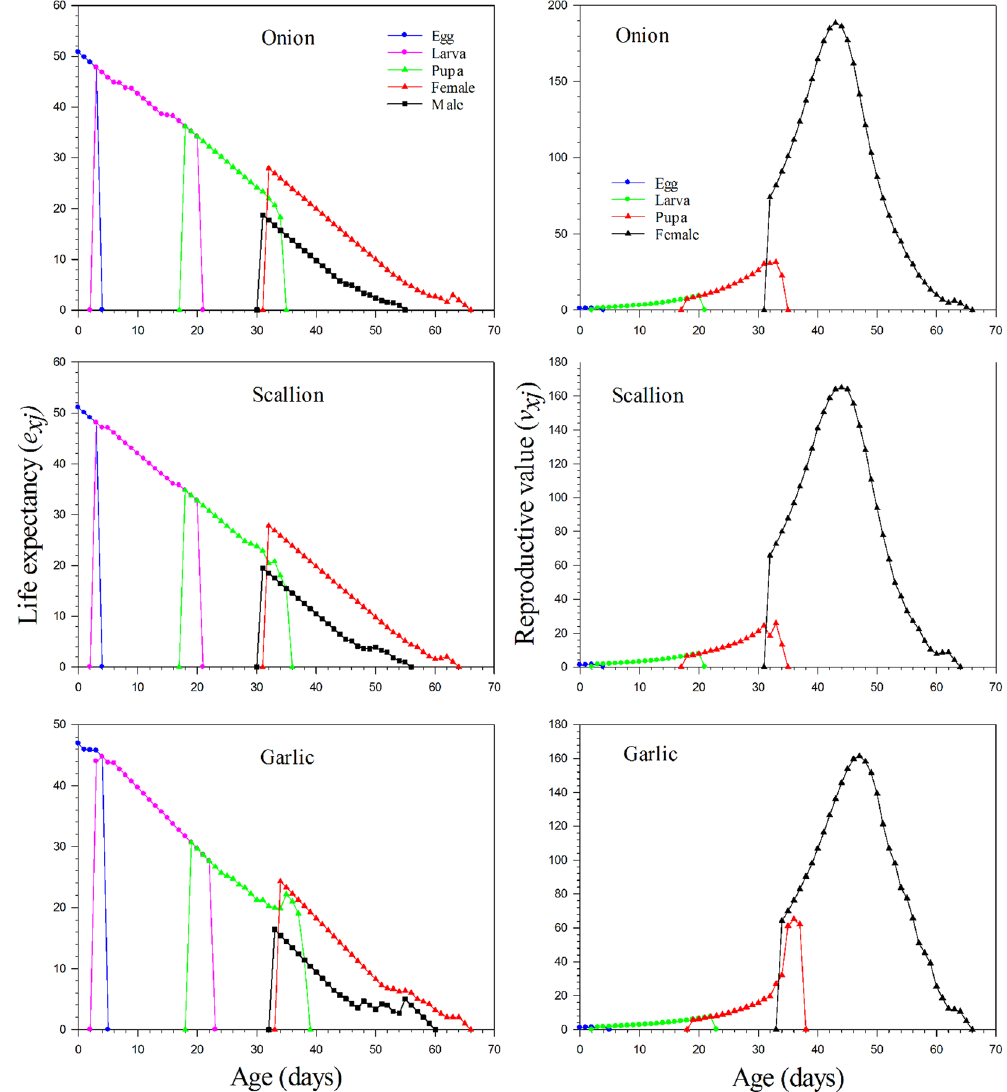
Figure 3. The age-stage life expectancy and reproductive value of Delia antiqua on different host plants of individually reared method. Left: The age-stage life expectancy; Right: The age-stage reproductive value.